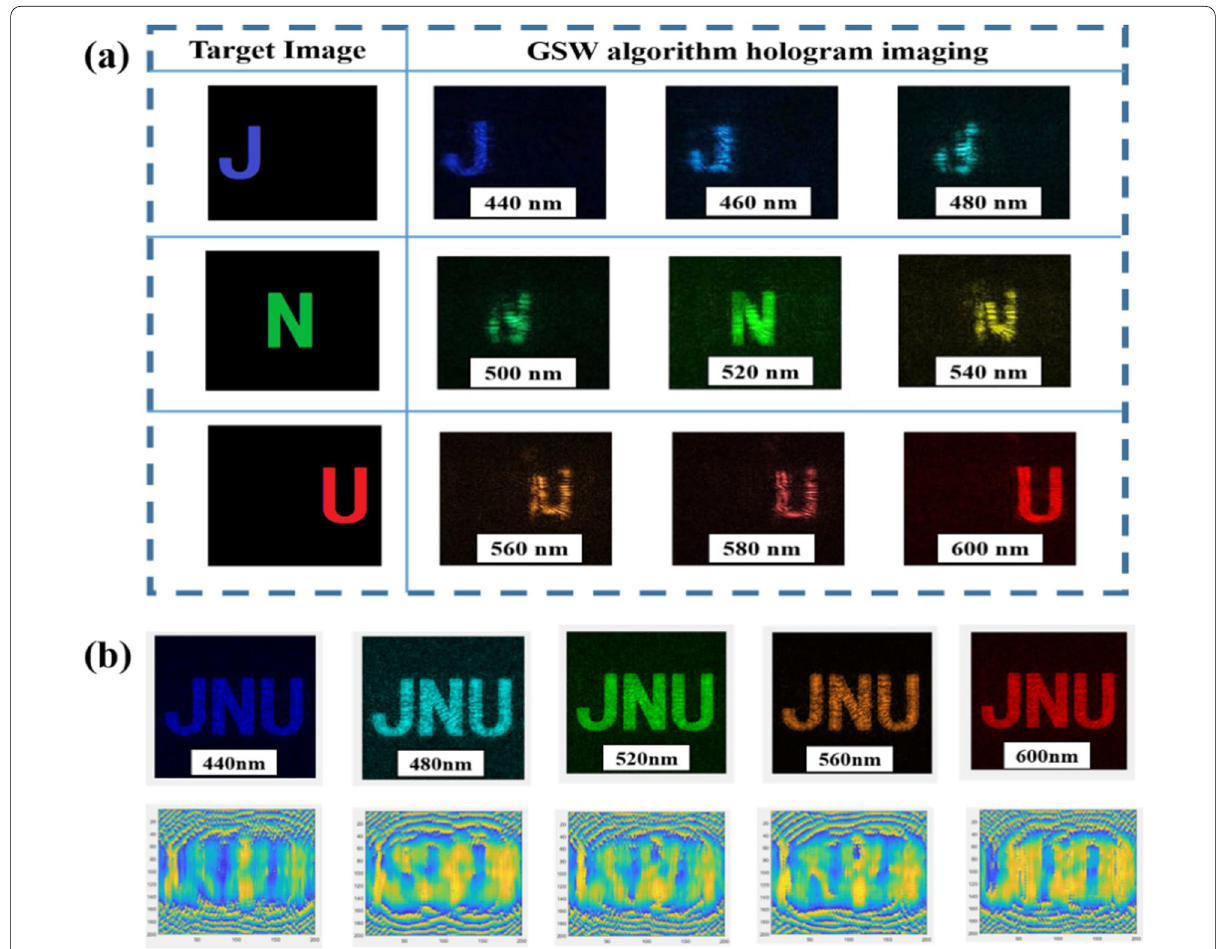
Fig. 5 a The resulting image of the GSW algorithm for a single wavelength iteration when incident on the three letters of “JNU” at 440 nm, 520 nm, and 600 nm, respectively. b Multiwavelength GSW iterative realization of “JNU” color image effect and phase